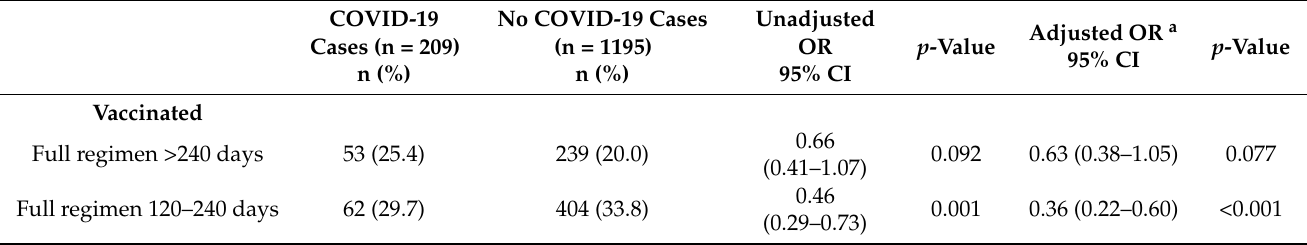
Table 2. Factors associated with SARS-CoV-2 infection in health care workers (n =